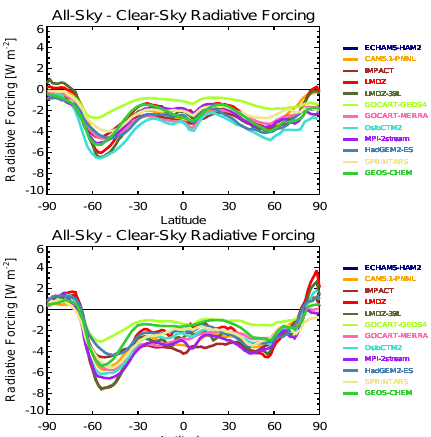
Fig. A7. Annual zonal-mean short-wave clear-sky and all-sky top-of-atmosphere radiative forcing with AOD=0.2 distributed over the lowest two kilometers between experiments with SSA=0.8 and SSA=1.0 with holding ANG=1.0 constant (FIX3-FIX2).